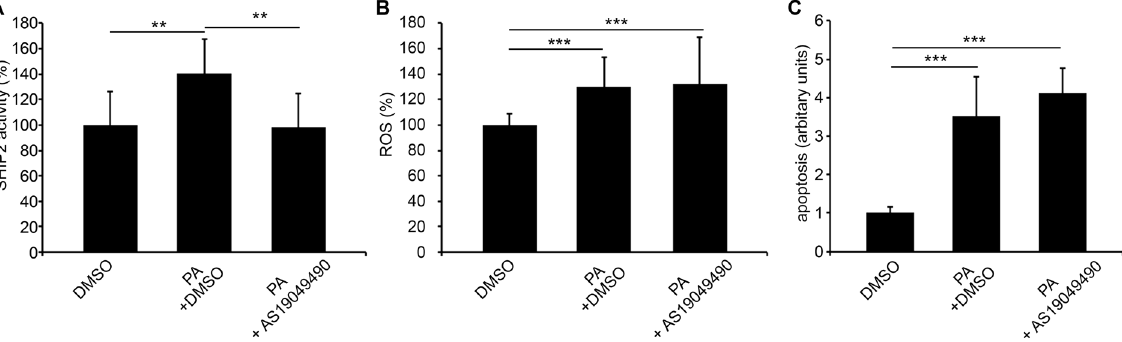
Figure 6. Inhibition of SHIP2 activity does not reduce PA-induced ROS generation or protect cultured human podocytes from apoptosis. ( A ) PA increases SHIP2 activity of cultured human podocytes. Simultaneous treatment of podocytes with PA and SHIP2 inhibitor AS1949490 prevents PA-induced increase in SHIP2 activity. ( B ) PA induces ROS generation in cultured human podocytes as observed by DCFH-DA fluorescent probe assay. Hoechst 33342 was used for normalization. Treatment of human podocytes with SHIP2 inhibitor AS1949490 does not prevent PA-induced increase in ROS generation. ( C ) PA induces apoptosis in cultured human podocytes as visualized by annexin V staining and FACS analysis. Treatment of human podocytes with SHIP2 inhibitor AS1949490 does not prevent PA-induced increase in apoptosis. The experiments were performed three times with four ( A ), 32 ( B ) or three ( C ) replicates in each experiment. The bars show the mean expression in arbitrary units (error bars STDEV). ** p < 0.01, *** p < 0.001, Student’s